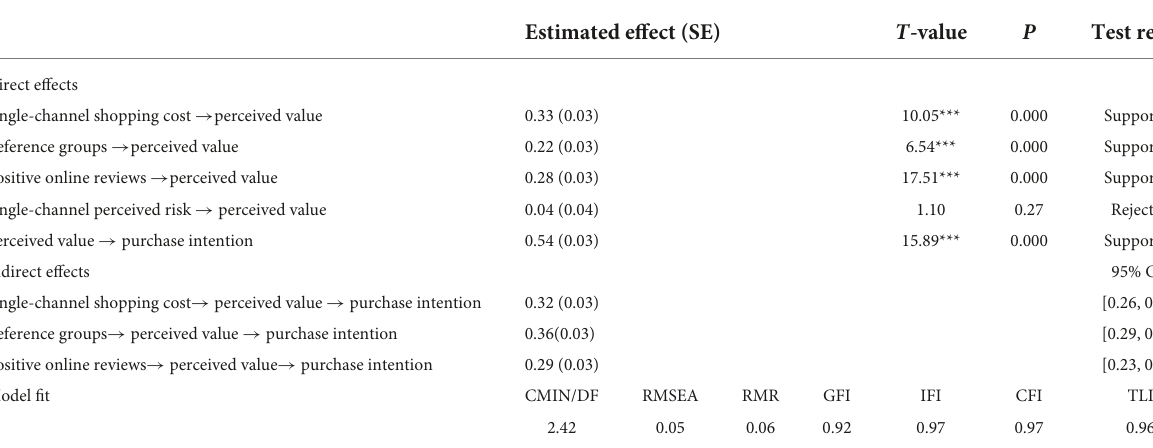
TABLE 5 Structural model